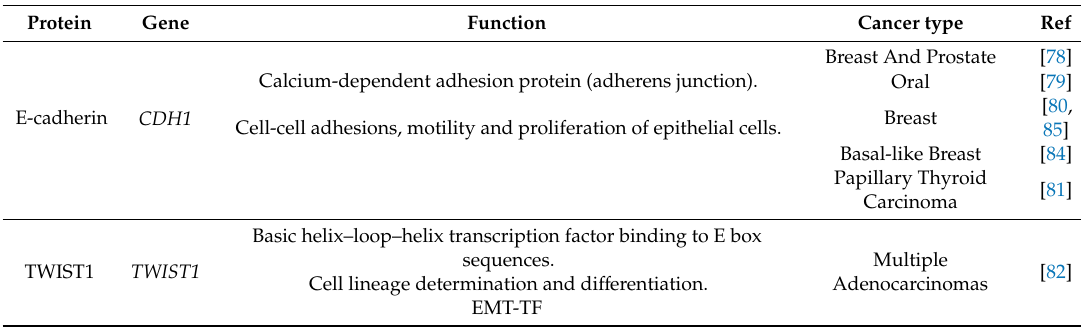
Basic helix–loop–helix transcription factor binding to E box sequences. TWIST1 TWIST1 Cell lineage determination and di ff erentiation.